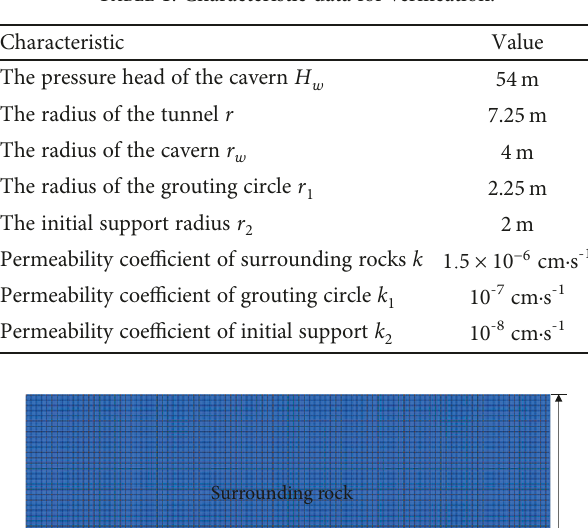
Table 1: Characteristic data for veri fi cation.